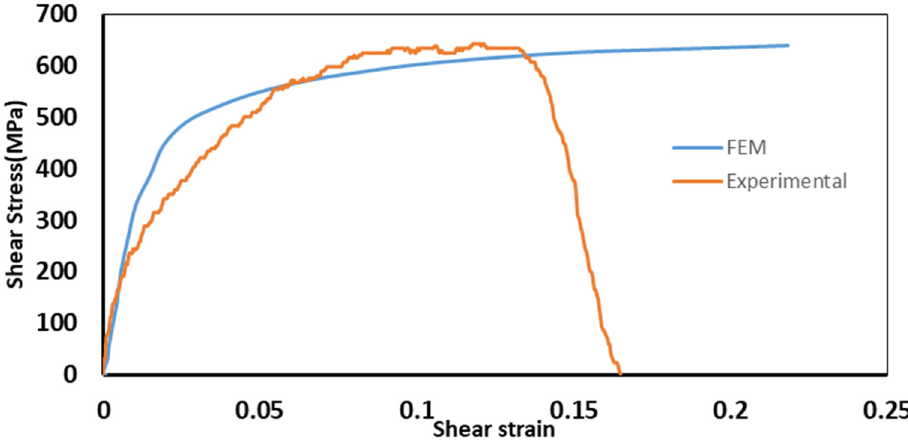
Figure 19. Shear stress–strain curve of the NSSS (t m = 1.5 mm) under a strain rate of 1000 s − 1 .